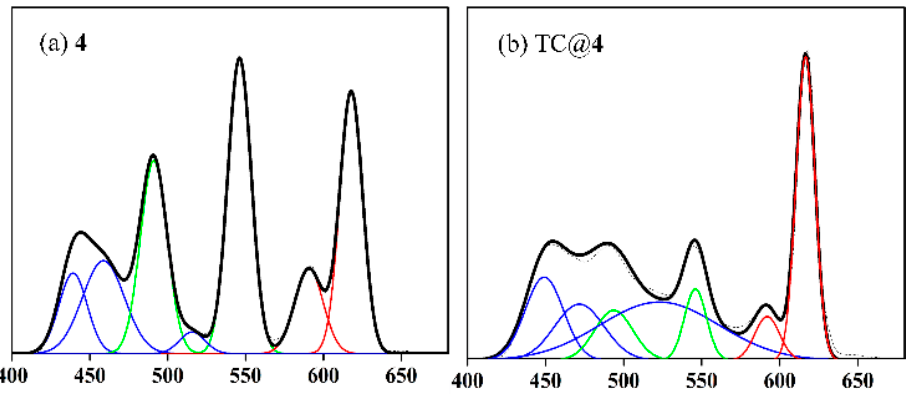
Figure 5. Fitting peaks analysis for complex ( a ) 4 and ( b ) TC@ 4 .